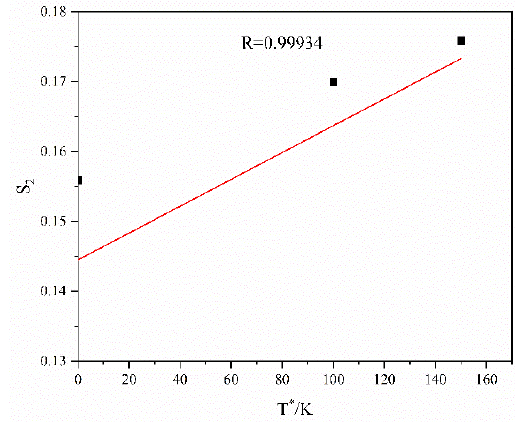
Figure 11. Linear fitting of S 2 against T ∗ .